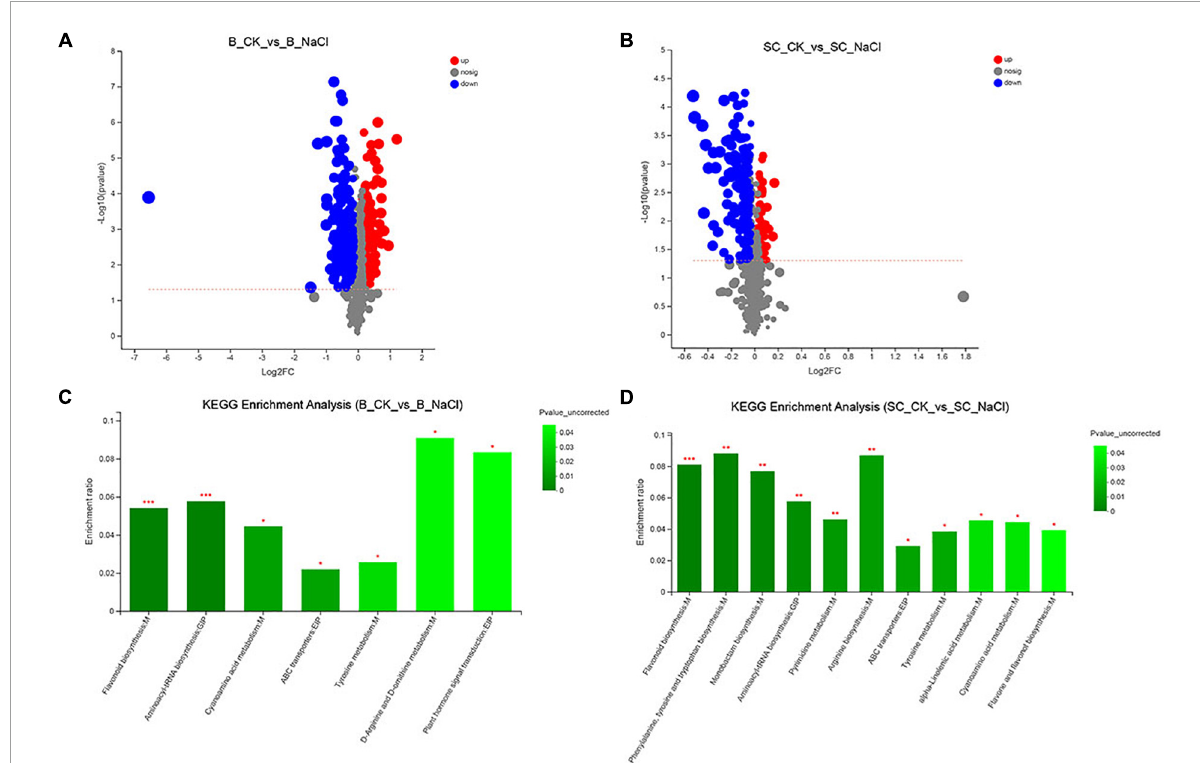
FIGURE6 The statistics of differentially accumulated metabolites and KEGG enrichment under salt stress in strawberry. ‘Sweet Charlie’ and ‘Benihoppe’ plants with 6–7 leaves were treated with 0 mM (control) or 100 mM NaCl solution, respectively. After 12 h of treatment, the young leaves were collected for metabolite extraction. Non-targeted metabolomic analysis was performed to expose the metabolomic changes of ‘Benihoppe’ and ‘Sweet Charlie’ in response to salt stress. The volcano map of differentially accumulated metabolites in ‘Benihoppe’ (A) and ‘Sweet Charlie’ (B) leaves under salt stress. KEGG pathways of differentially accumulated metabolites in ‘Benihoppe’ (C) and ‘Sweet Charlie’ (D) under salt